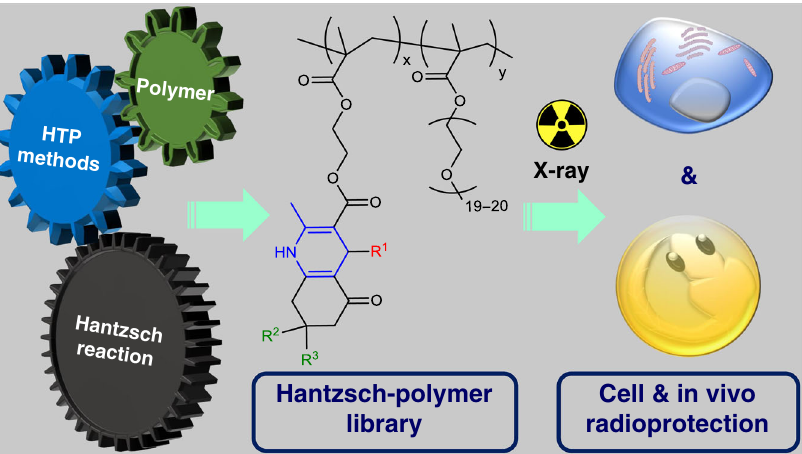
Fig. 1 Anti-radiation polymers based on Hantzsch ’ s reaction. Exploration of anti-radiation polymers by combining Hantzsch ’ s reaction, HTP technology and polymer chemistry.